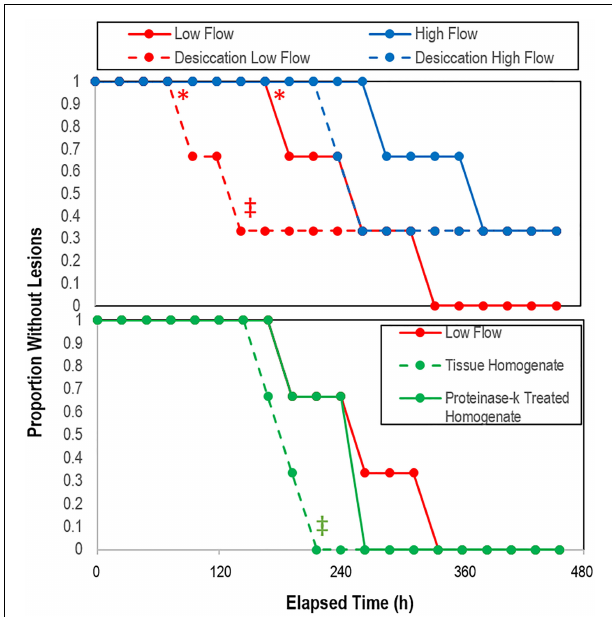
FIGURE 8 | Proportion grossly normal P. ochraceus over time in response to treatment (top) desiccation ( n = 3), and (bottom) treatment with crude and proteinase k-treated tissue homogenates ( n = 2). * indicates that low flow lesion genesis time was significantly different ( p < 0.05, Student’s t -test) to high flow rate; ‡ indicates that the overall trend of desiccation under low vs high flow rate and with the addition of proteinase-k treated homogenate vs. low flow controls was significant ( p < 0.05, log-rank